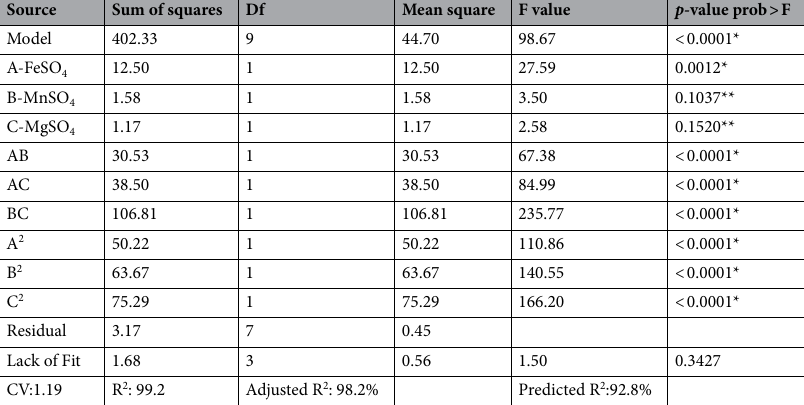
Table 5. Regression coefficients and statistical significance for the quadratic model. Symbols used : *, Significant terms; **, non-significant terms; AB-interactive term for FeSO 4 and MnSO 4 ; AC-interactive term for FeSO 4 and MgSO 4 ; BC-interactive term for MSO 4 and MgSO 4